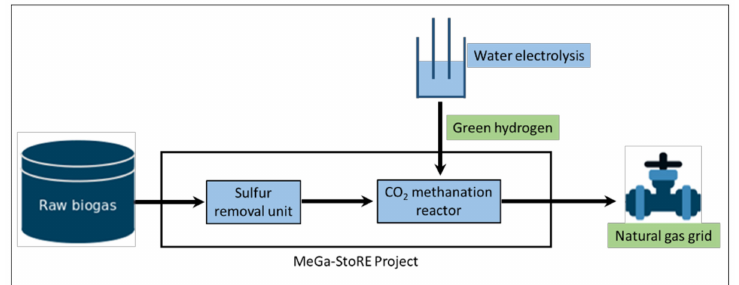
Figure 1. Schematic presentation of the MeGa-StoRE project, including the methanation container and Green Hydrogen container.